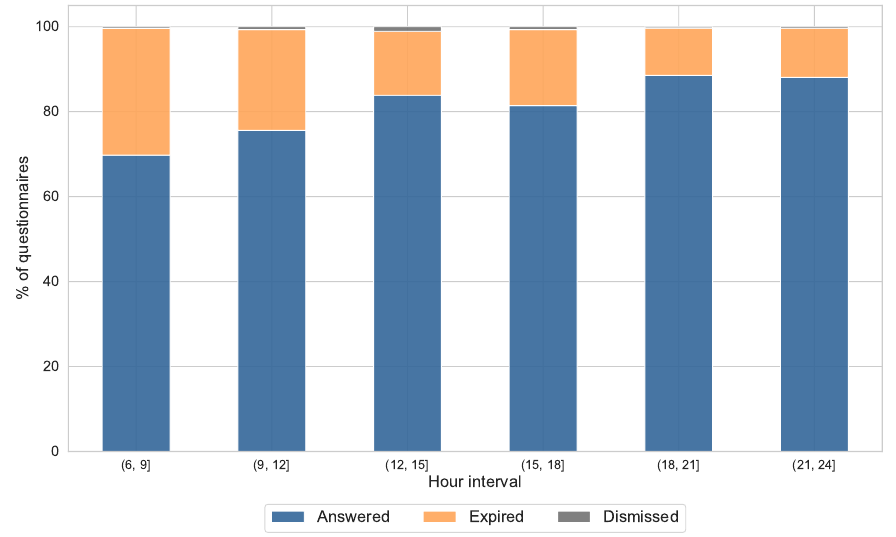
Figure 7. Overall percentage of questionnaires answered (blue), expired (orange) and actively dismissed (grey) per interval of daily